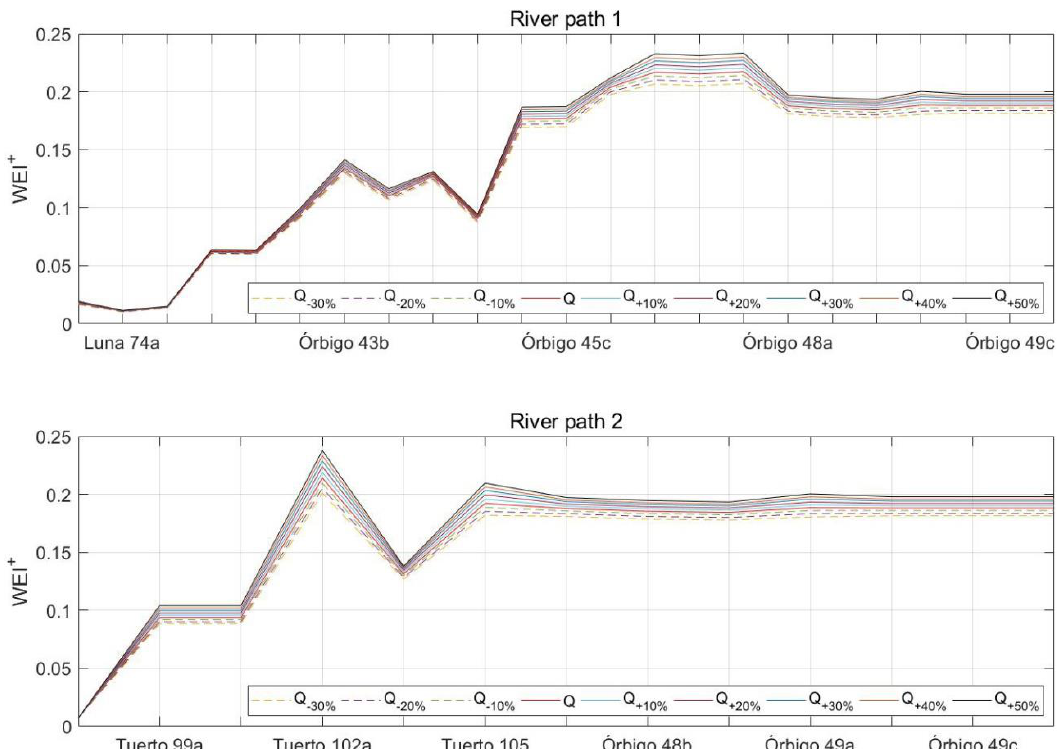
Figure 8. WEI + values for each environmental flow scenario along the two river paths indicated in Figure 1.